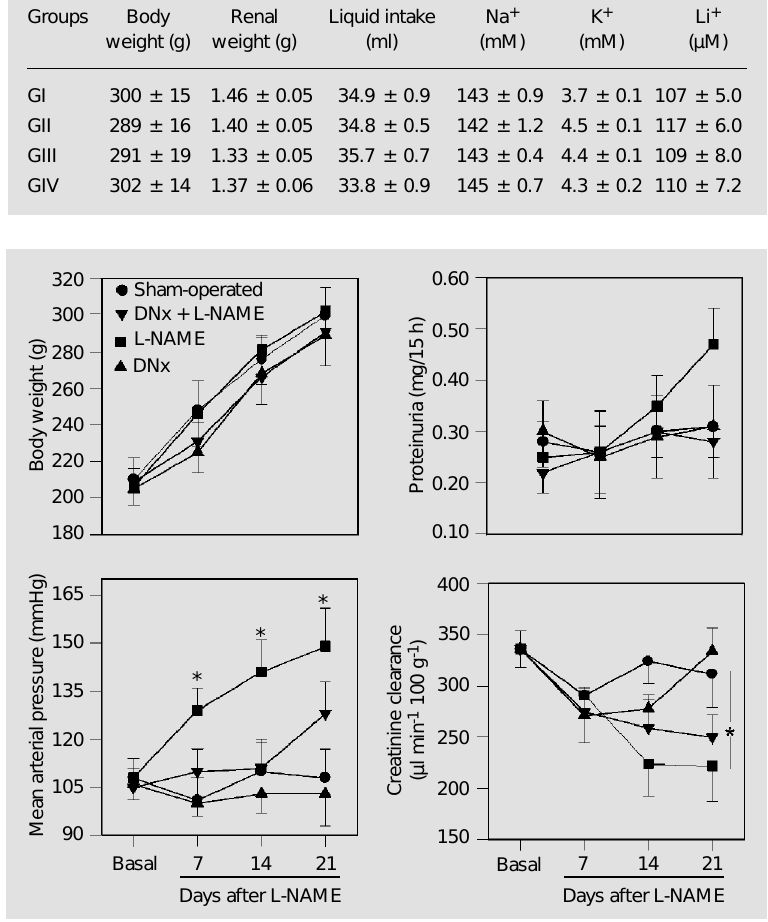
test).Table 1 - Effect of the oral administration of vehicle (group I, GI), or L-NAME (GII) to sham-operated rats on body weight, renal weight and serum sodium, potassium and lithium levels compared to similar vehicle (GIII) or L-NAME (GIV) administration to bilaterally renal denervated